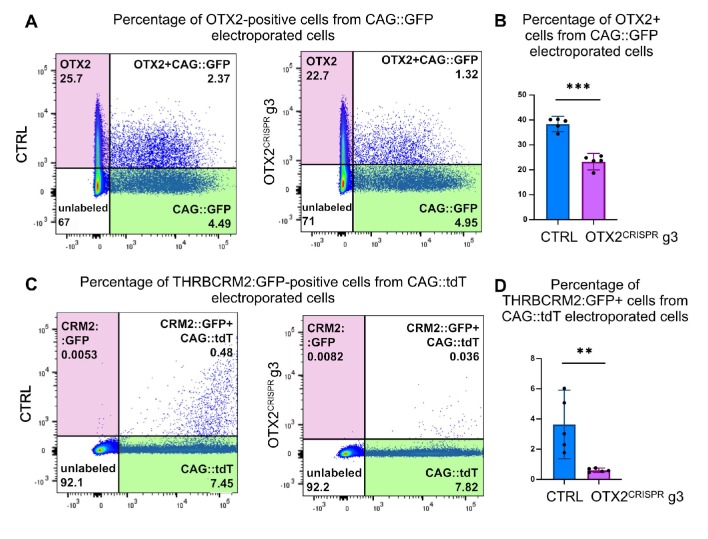
Flow cytometry quantification of OTX2 immunoreactivity and THRBCRM2 activity in OTX2CRISPR g3 retinas.Representative dot plots showing the overlap between OTX2 immunoreactivity (A–B) and THRBCRM2::GFP (C–D) with CAG::GFP or CAG::tdT in CTRL and OTX2CRISPR g3 dissociated retinas. Percentage of cells positive for each marker were normalized to the total number of electroporated cells detected with GFP or tdT. *** signifies p<0.0001 and ** signifies p<0.001. Error bars represent 95% confidence intervals, n = 5 each for CTRL and OTX2CRISPR g3.